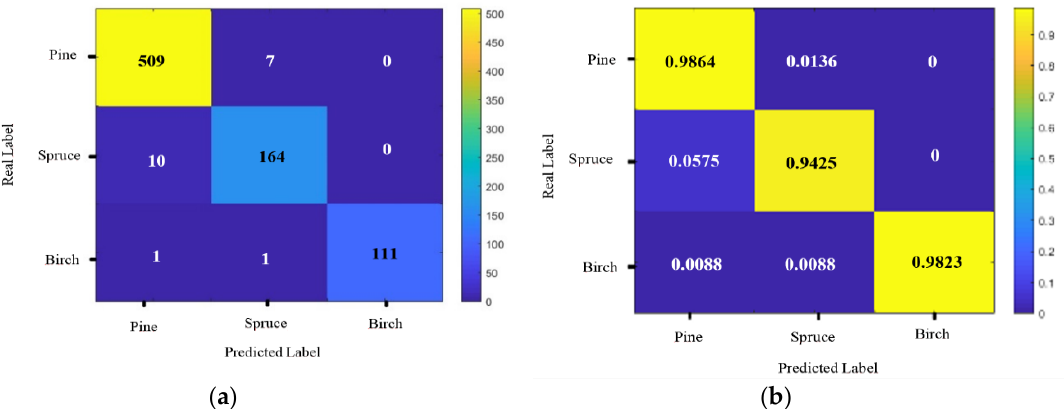
Figure 10. Confusion matrices of the 3D-CNN with all 37 input layers ( HS+RGB+CHM); ( a ) case numbers, ( b ) normalized percentages.